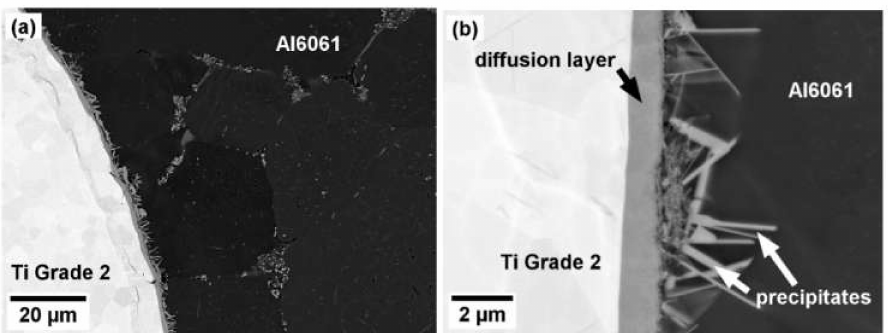
Figure 4. ( a ) Ti Grade 2/Al6061 interface with a diffusion layer and precipitates in the Al6061 matrix, ( b ) A detail of the diffusion layer in Ti Grade 2; the precipitates in Al6061 are growing from the diffusion layer.